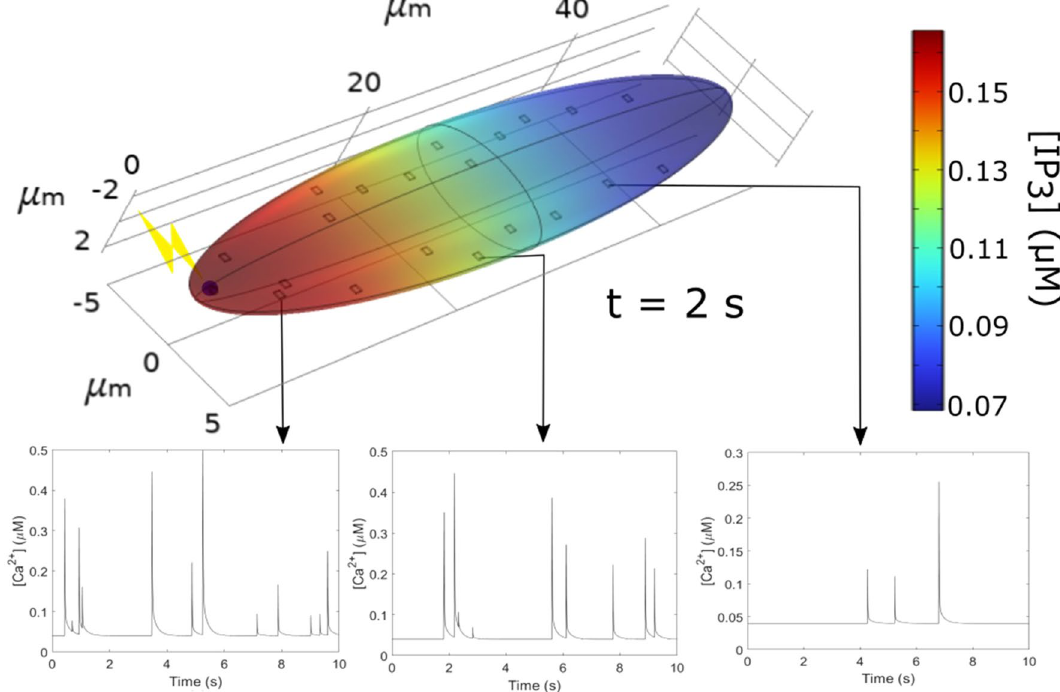
Figure 6. Computational simulations of IP 3 diffusion and Ca 2+ puff occurrence in response to the localized photorelease of a non-metabolizable IP 3 analogue in an ellipsoidal 3D geometry, assuming an effective diffusion coefficient of IP from the flash. Simulation procedures are the same as for Fig. 4. The rate of localized IP 3 photorelease, θ, is taken equal to 2500 μMs −1 , which allows to obtain the same spatiotemporal profile of IP 3 increase as the 250 μMs −1 value for the 2D case, because of changes in